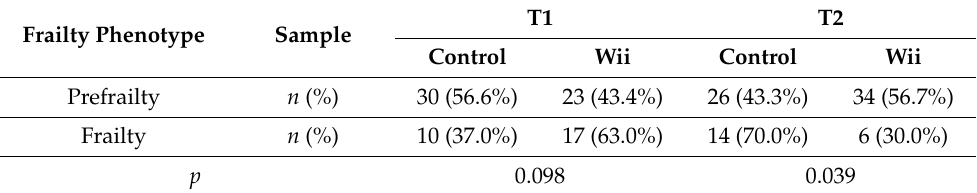
Table 2. Frailty phenotype distribution in pretest (T1) and post-test (T2) in control and Wii groups. Frailty